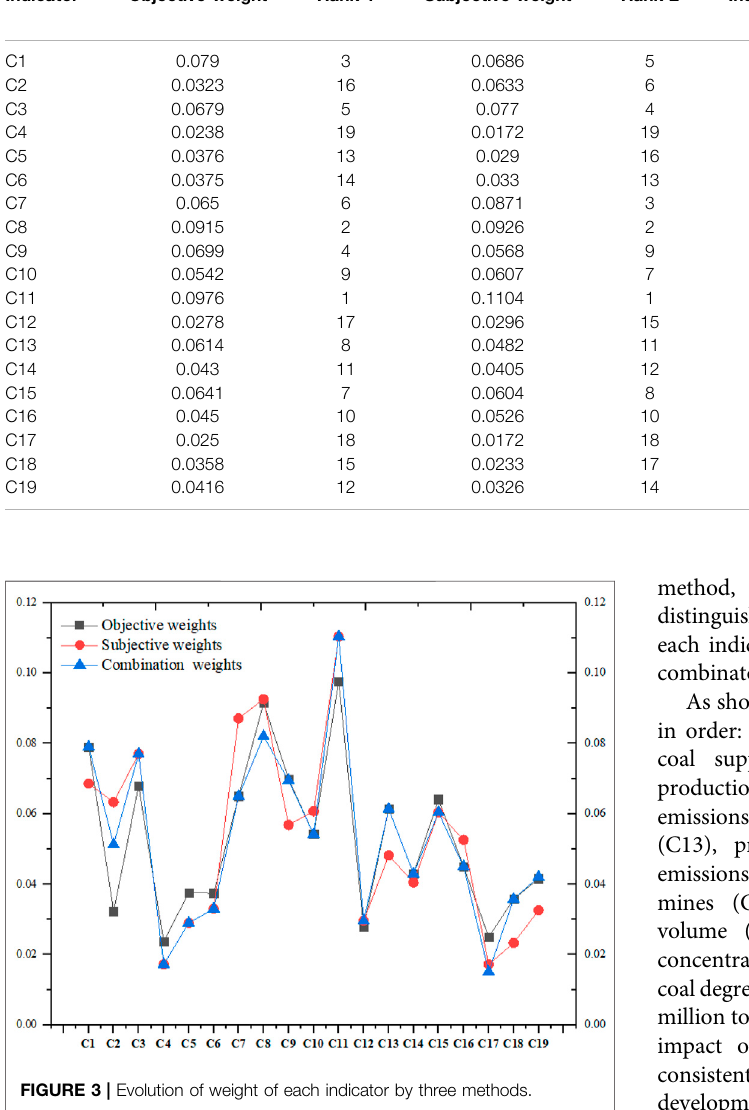
TABLE 3 | Combination weighting results by maximizing the level difference method. Indicator Objective weight